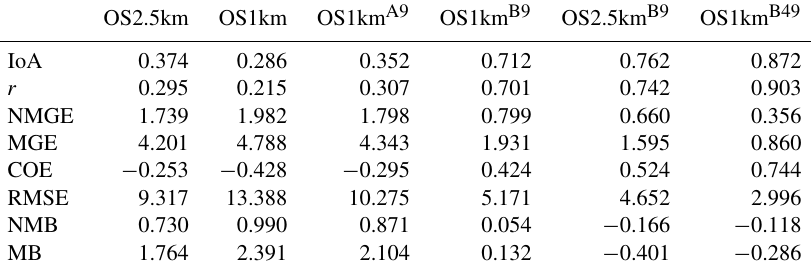
Table B1. Surface SO 2 observations to model comparison, daytime (09:00–18:00LT) (ppbv, 2119 model–observation